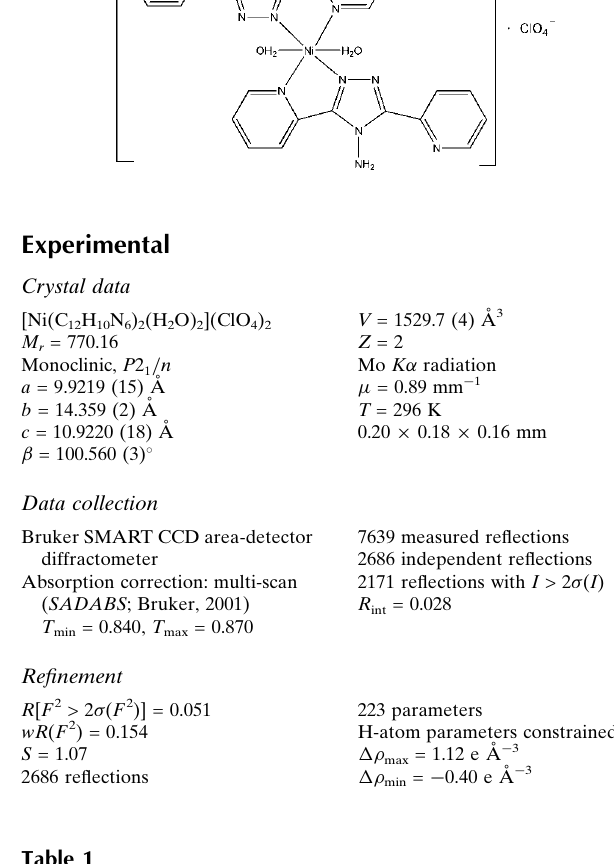
Hydrogen-bond geometry (A˚ , (cid:2)